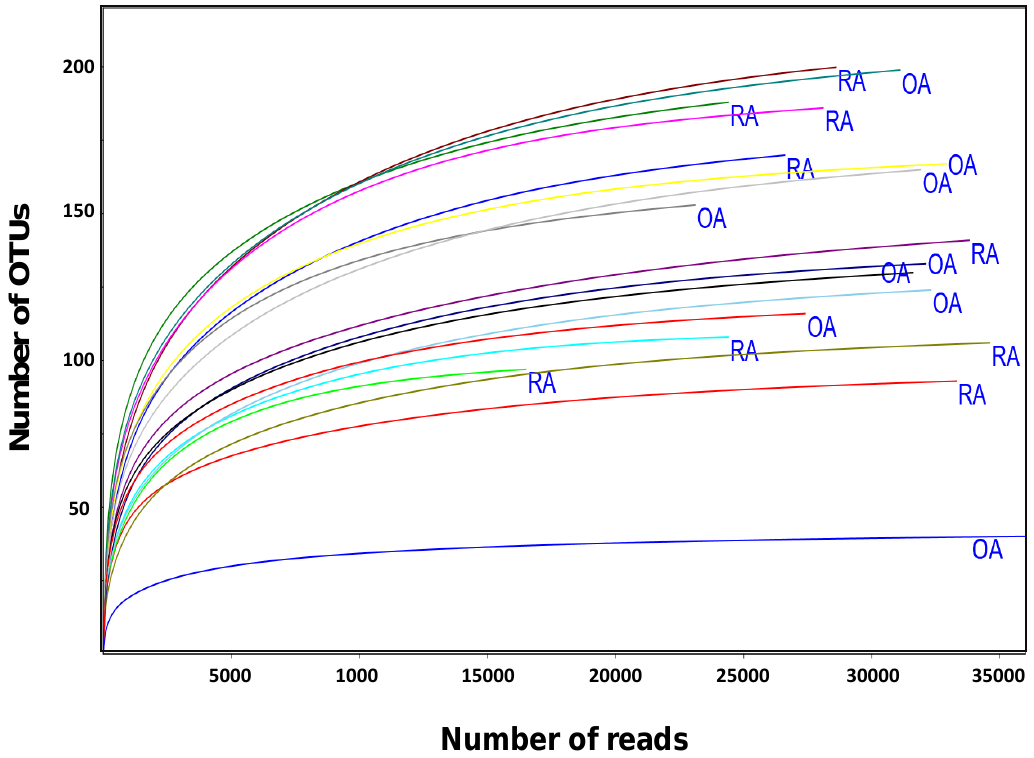
Figure 1. Rarefaction curves of the numbers of reads and the number of assigned phylotypes from the fecal sample of rheumatoid arthritis (RA) and osteoarthritis (OA)